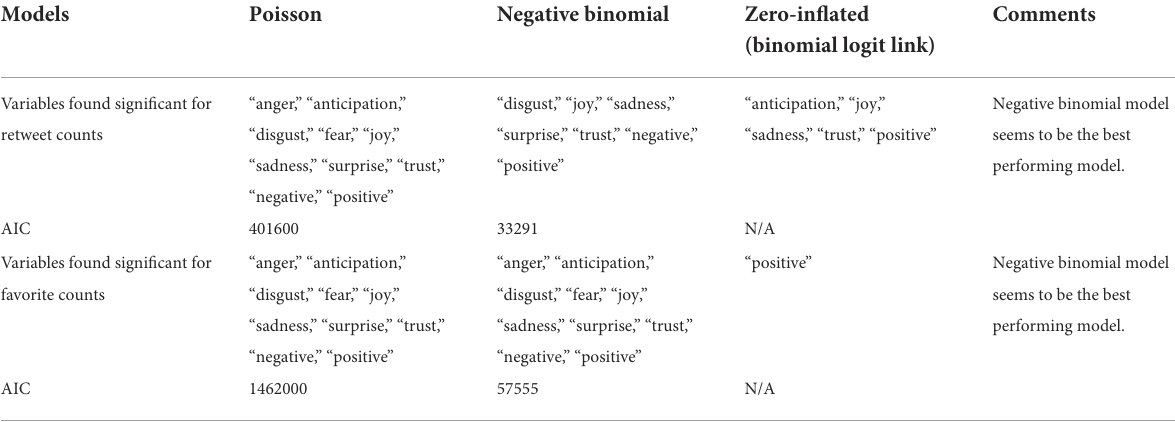
TABLE 1 Variable selection in models of retweet and favorite counts with sentiment scores.